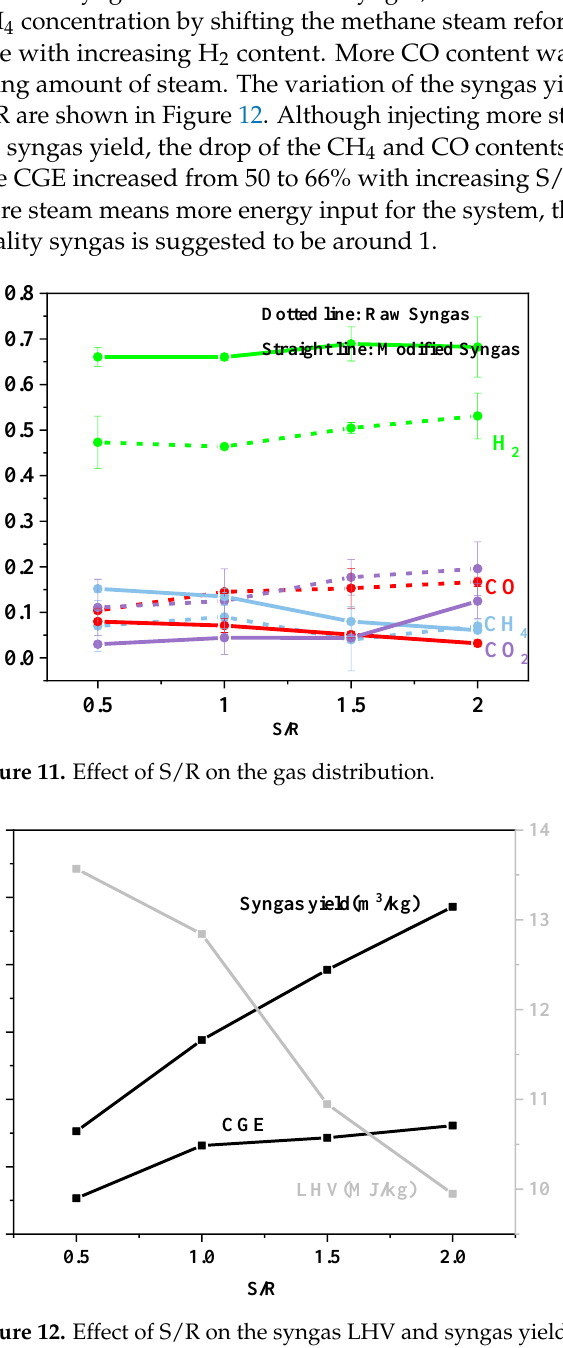
Figure 12. Effect of S/R on the syngas LHV and syngas yield for modified syngas.